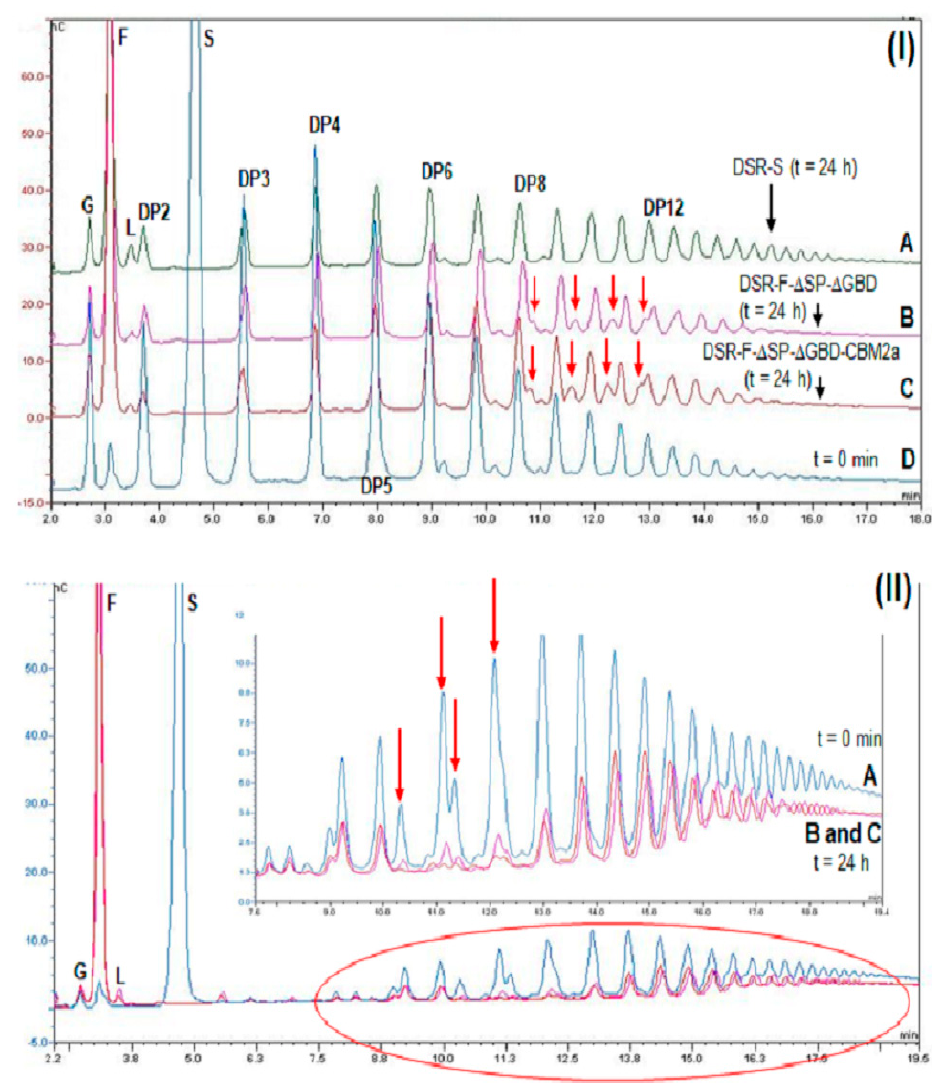
Figure 5. ( I ) Analysis of HPAEC-PAD chromatogram products synthesized using the chimeric dextransucrase DSR-F- ∆ SP- ∆ GBD-CBM2a, DSR-F- ∆ SP- ∆ GBD and native dextransucrase DSR-S from Leuconostoc mesenteroides NRRL B-512F from sucrose (292 mM) and dextran 1500 g·mol − 1 (66.6 mM) with 20 mM sodium acetate buffer, pH 5.5 and 1 U·mL − 1 enzyme. Enzymatic reactions were stopped after 24 h, nC, (nanocoulombs). I -(A) Enzymatic reaction using DSR-S from L. mesenteroides NRRL–B512; I -(B) enzymatic reaction using DSR-F- ∆ SP- ∆ GBD recombinant; I -(C) enzymatic reaction using chimeric dextransucrase DSR-F- ∆ SP- ∆ GBD-CBM2a; I -(D) enzymatic reaction using chimeric dextransucrase DSR-F- ∆ SP- ∆ GBD-CBM2a at the initial time (t = 0 min). Arrows indicate four extra peaks immediately after the products with degrees of polymerization (DP) of 8–12, respectively. ( II ) Analysis of HPAEC-PAD chromatogram products synthesized using the chimeric dextransucrase DSR-F- ∆ SP- ∆ GBD-CBM2a and DSR-F- ∆ SP- ∆ GBD sucrose (292 mM) and 6000 g·mol − 1 dextran (66.6 mM) with 20 mM sodium acetate buffer, pH 5.5 and 1 U·mL − 1 enzyme. Enzymatic reactions were stopped after 24 h. II -(A) Enzymatic reaction using chimeric dextransucrase DSR-F- ∆ SP- ∆ GBD-CBM2a at the initial time (t = 0 min); II -(B) and II -(C) enzymatic reaction using DSR-F- ∆ SP- ∆ GBD-CBM2a and DSR-F- ∆ SP- ∆ GBD, respectively. Arrows indicate peaks corresponding to modified dextrans from the initial reaction time. Peak identification: G—glucose, F—fructose, L—leucrose, S—sucrose, DP2–DP12 — isomaltooligosaccharides with a degree of polymerization (DP) from 2 to 12.